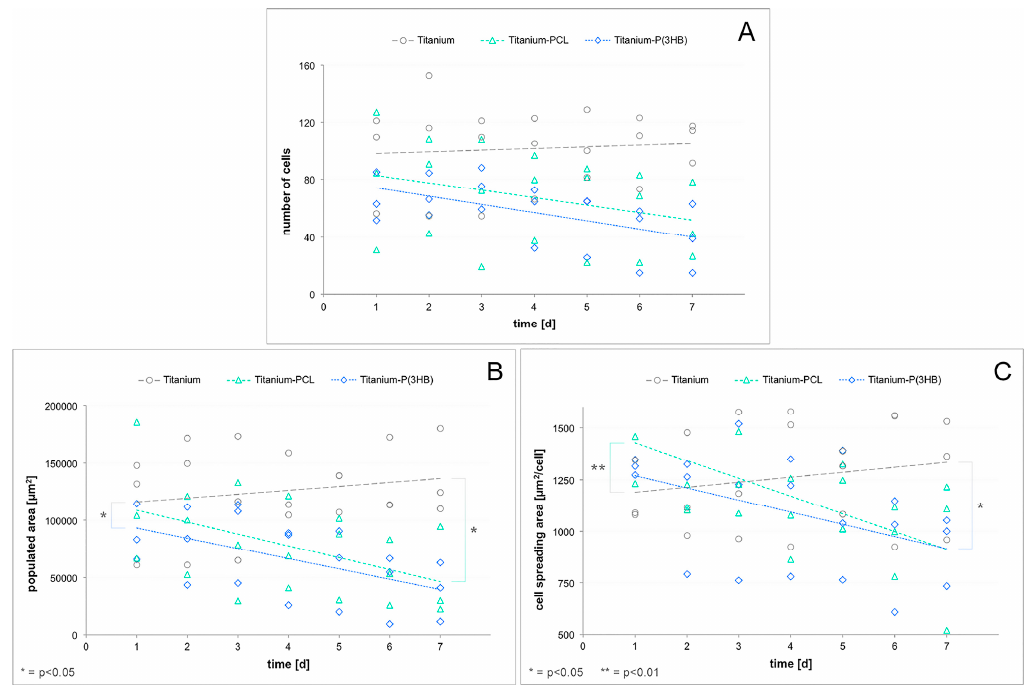
Figure 9. GFP-linked osteoblasts on an uncoated ( A – C ), PCL-coated ( D – F ) or P(3HB)-coated ( G – I ) titanium scaffold on day 0 ( A , D , G ), 3 ( B , E , H ) and 7 ( C , F , I ). The pictures were taken at a 10-fold magnification (scale bar: 250 µm).